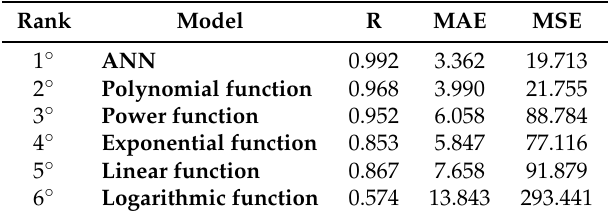
Table 10. Effective functions versus ANN for forecasting